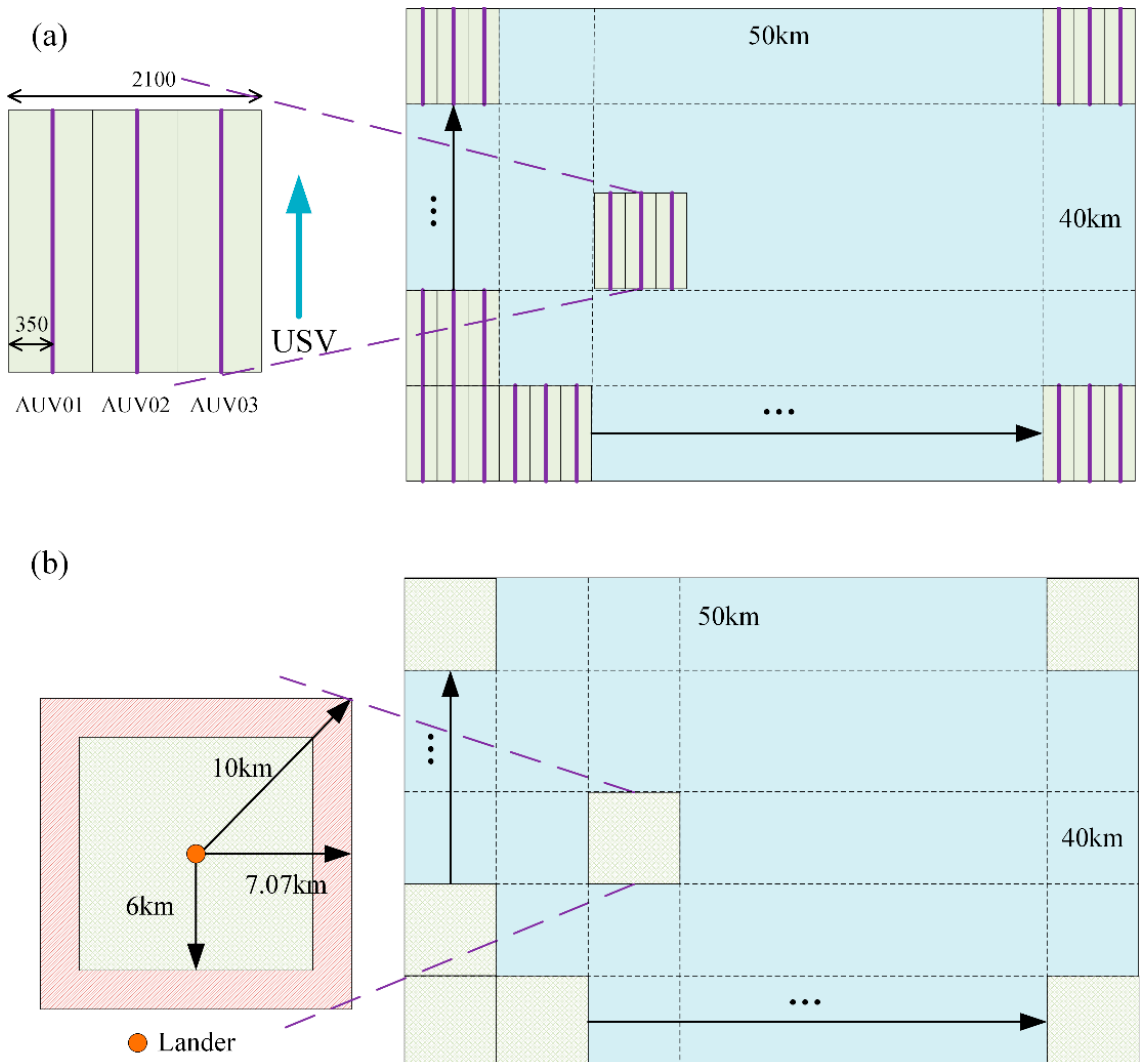
Figure 18. ( a ) Operation based on USV mode. ( b ) Work based on lander mode. Table 1. Operational time and dive times of the three cooperative operational modes.